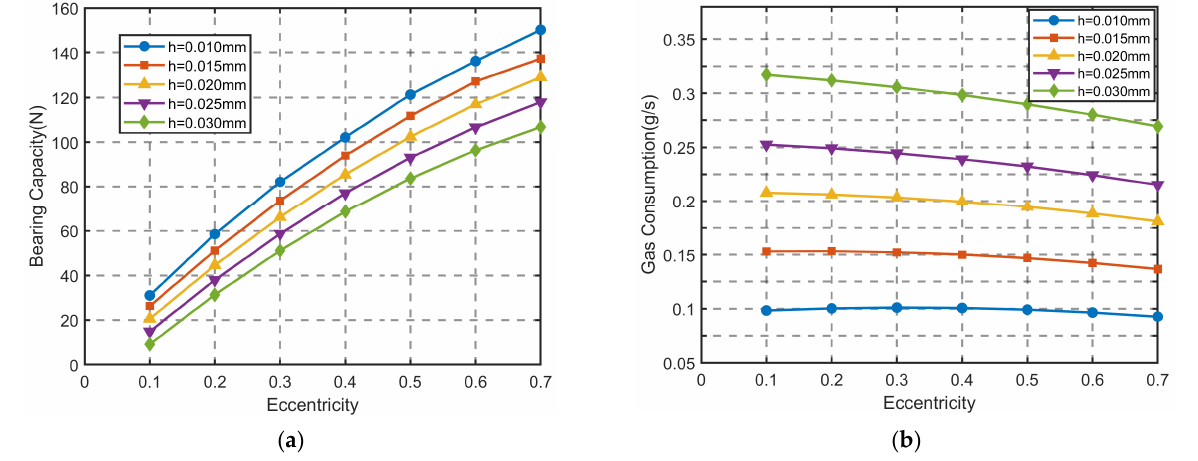
Figure 8. Influence of average film thickness on ( a ) bearing capacity and ( b ) gas consumption.